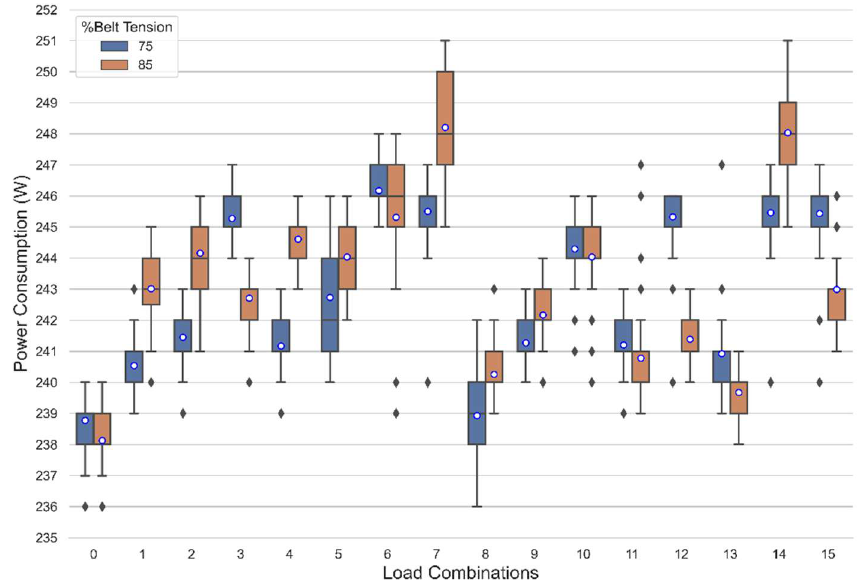
Figure 9. Effect of belt tension (75–85%) and load on conveyor motor driver power consumption. Table 5. Dynamic case results for 75–85% belt tension with no active zones. Belt Tension (%)